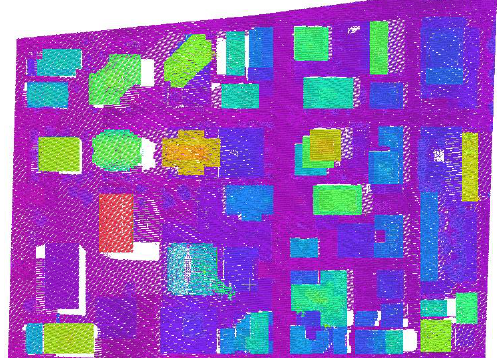
Figure 6. Overview of Toronto test area colorized by